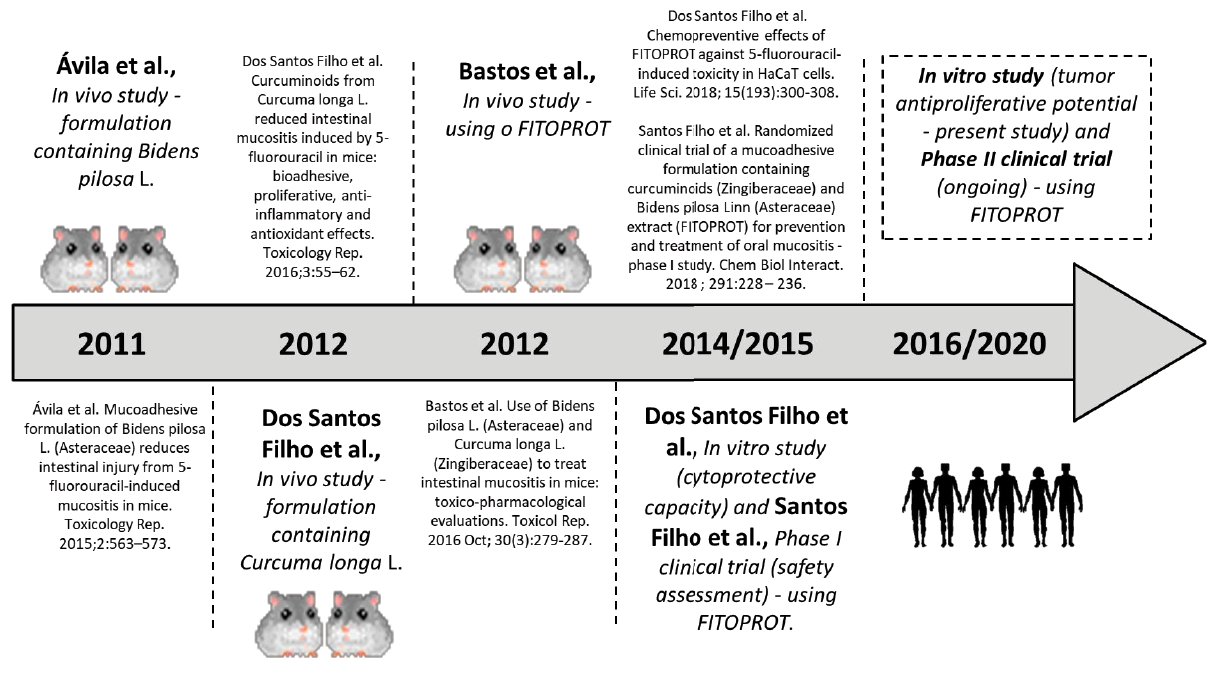
Figure 1. Schematic representation of studies performed and in progress using FITOPROT.